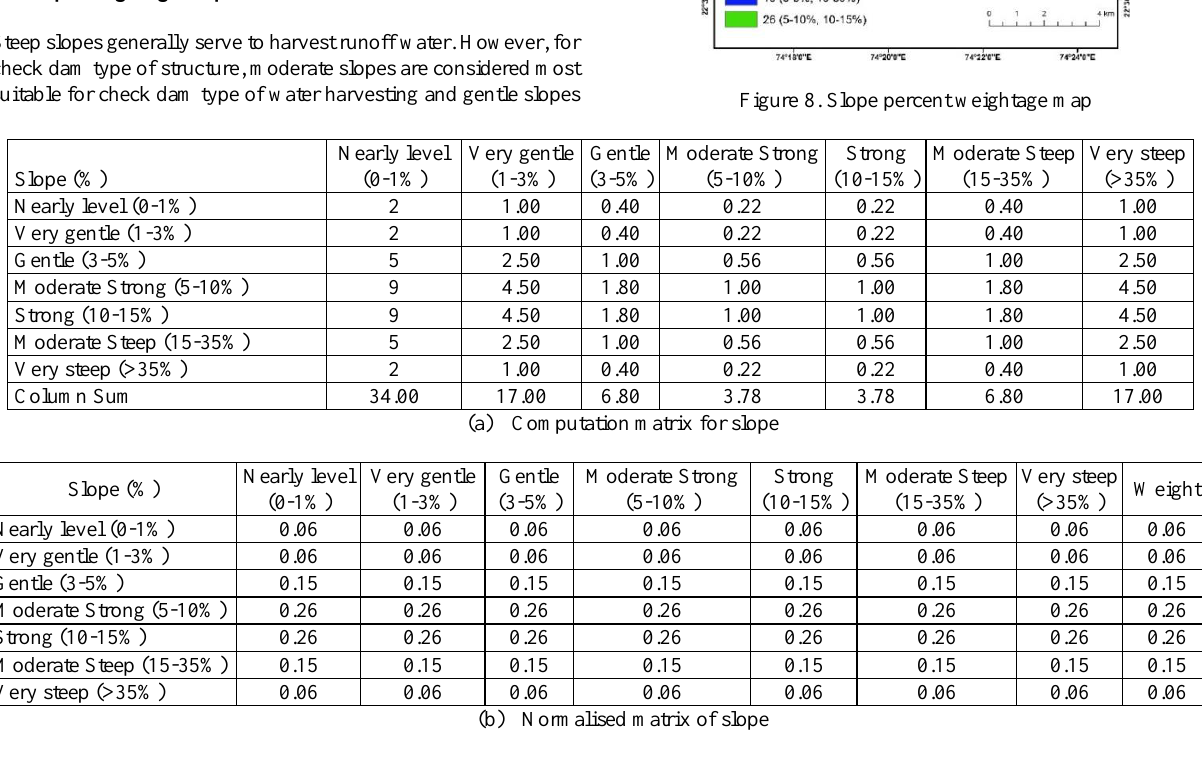
Table 5. Deriving the relative weights of the slope